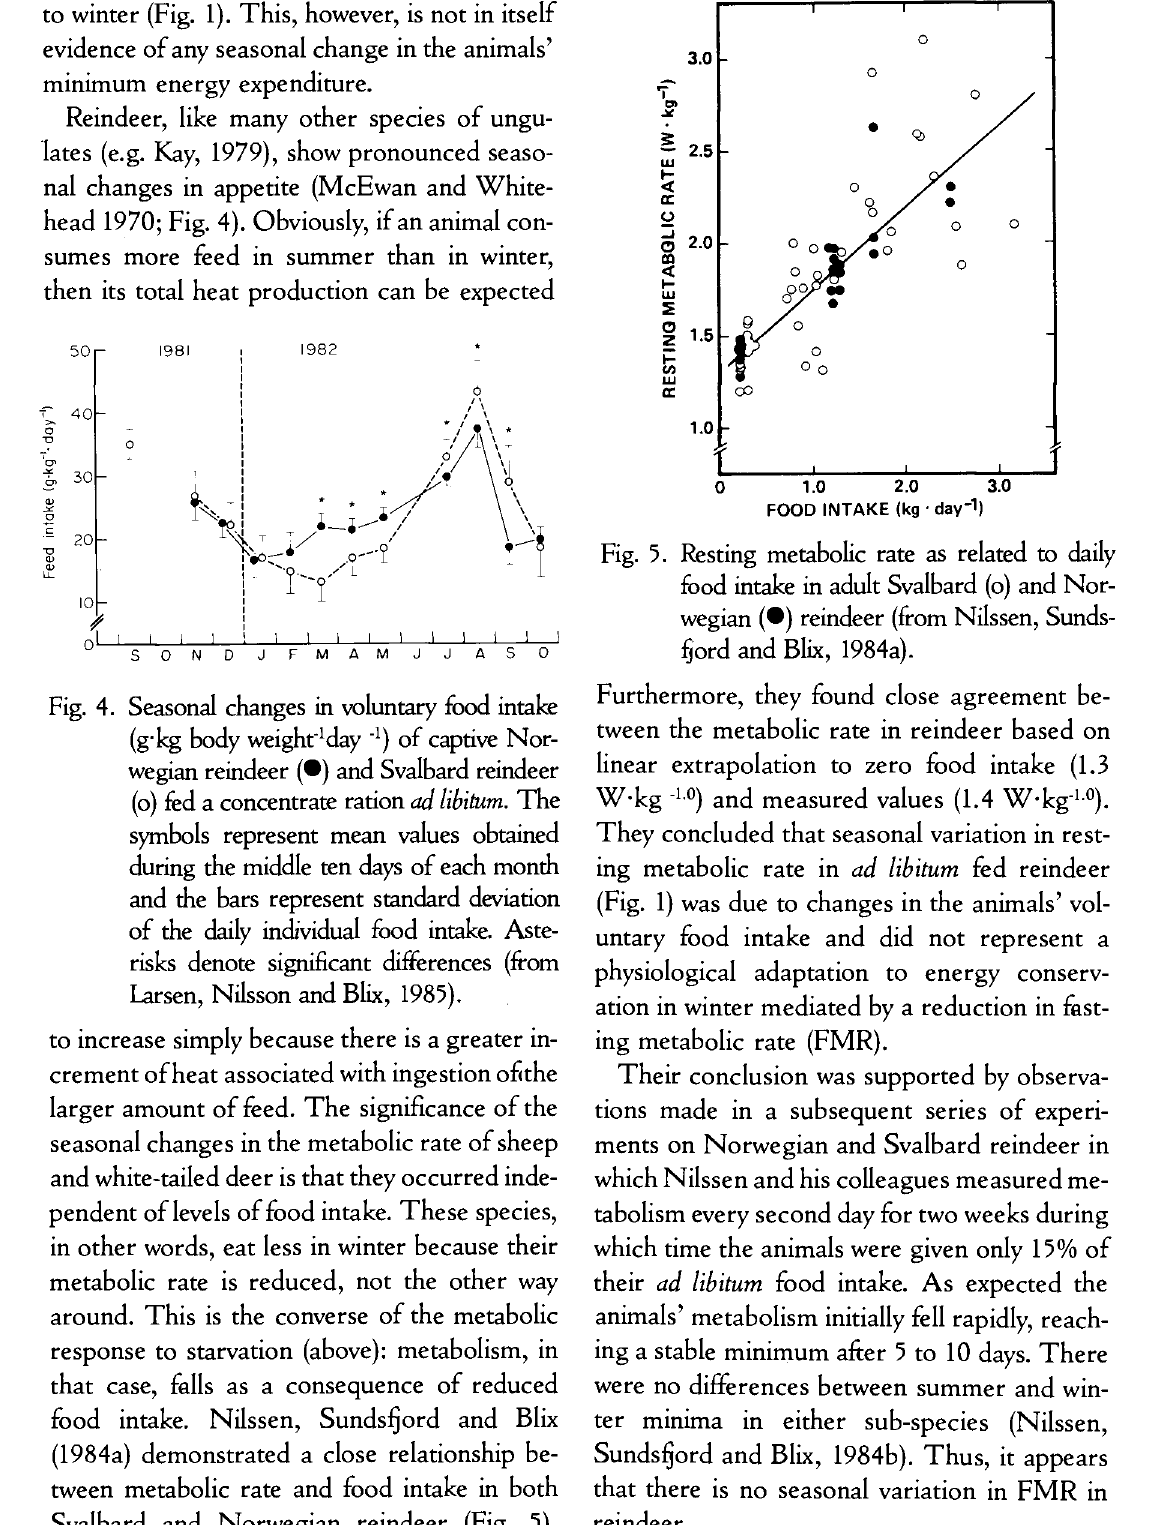
Fig. 5. Resting metabolic rate as related to daily food intake in adult Svalbard (o) and Nor wegian (•) reindeer (from Nilssen, Sunds fjord and Blix, 1984a). Furthermore, they found close agreement be Fig. 4. Seasonal changes in voluntary food intake tween the metabolic rate in reindeer based on (g'kg body weight 4 day "') of captive Nor linear extrapolation to zero food intake (1.3 wegian reindeer (•) and Svalbard reindeer W-kg 10 ) and measured values (1.4 W-kg- 1 - 0 ). (o) fed a concentrate ration ad libitum. The They concluded that seasonal variation in rest symbols represent mean values obtained during the middle ten days of each month ing metabolic rate in ad libitum fed reindeer and the bars represent standard deviation (Fig. 1) was due to changes in the animals' vol of the daily individual food intake. Aste untary food intake and did not represent a risks denote significant differences (from physiological adaptation to energy conserv Larsen, Nilsson and Blix, 1985). ation in winter mediated by a reduction in fast ing metabolic rate (FMR). to increase simply because there is a greater in crement of heat associated with ingestion of the Their conclusion was supported by observa larger amount of feed. The significance of the tions made in a subsequent series of experi seasonal changes in the metabolic rate of sheep ments on Norwegian and Svalbard reindeer in and white-tailed deer is that they occurred inde which Nilssen and his colleagues measured me pendent of levels of food intake. These species, tabolism every second day for two weeks during which time the animals were given only 15% of their ad libitum food intake. As expected the animals' metabolism initially fell rapidly, reach ing a stable minimum after 5 to 10 days. There were no differences between summer and win ter minima in either sub-species (Nilssen, Sundsfjord and Blix, 1984b). Thus, it appears tween metabolic rate and food intake in both that there is no seasonal variation in F MR in Svalbard and Norwegian reindeer (Fig. 5).